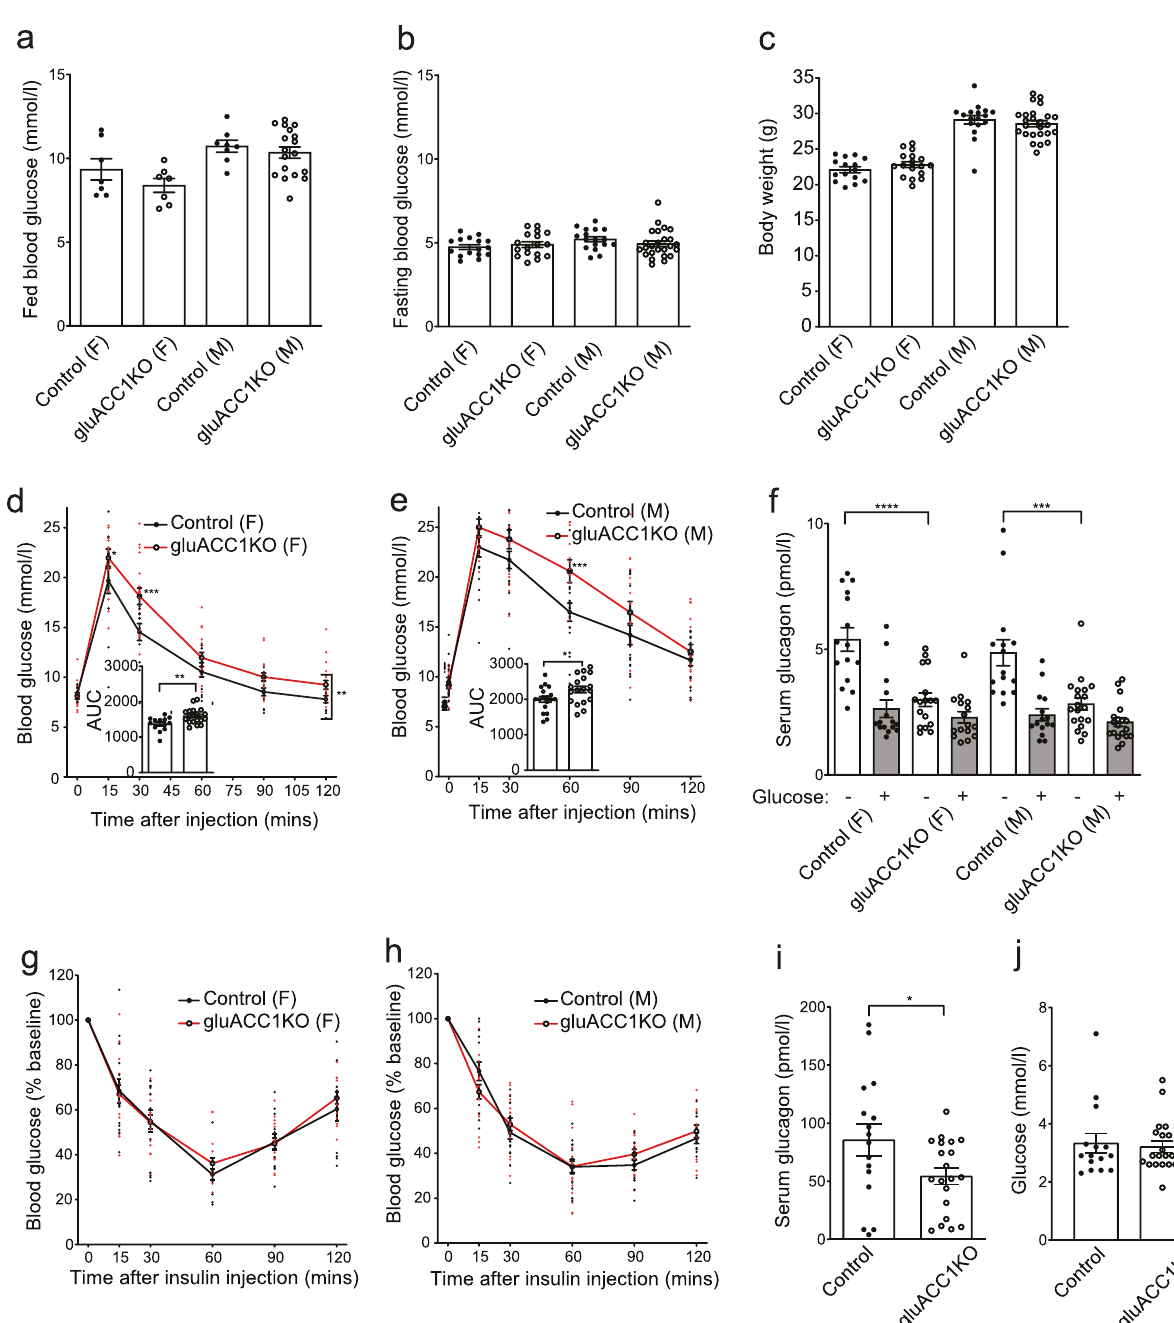
Fig. 2 Genetic inactivation of ACC1 in alpha-cells impairs glucagon secretion in vivo. a , b Blood glucose levels measured in 20 – 22 week old control (black circles) and gluACC1KO (white circles) mice in the fed ( a ; n = 7 – 18) and 16 h fasted ( b ; n = 16 – 25) states. c Body weight measured in 20 – 22-week-old control (black circles) and gluACC1KO (white circles) mice ( n = 15 – 25 mice). d , e Blood glucose levels and AUC during an IPGTT (6 h fast; 2 g/kg glucose dose) performed in 12 – 14-week-old female ( d ; n = 13 – 19) and male ( e ; n = 18) mice. Trace data analysed by two-way ANOVA ( P = 0.0009 for genotype effect in ( d ) with Fisher ’ s LSD test indicated. AUC was analysed by t -test. f Serum glucagon levels during the IPGTT at time 0 (white bars) and 30 min post-glucose injection (grey bars). Data from n = 15 – 19 mice analysed by t -test. g , h Insulin tolerance test (ITT) performed following 6 h fasting in female mice injected i.p. with 0.5 U/kg insulin ( g ; n = 16-17), or male mice injected i.p. with 0.75 U/kg insulin ( h ; n = 16 – 19). i , j Serum glucagon ( i ) and blood glucose ( j ) concentrations 60 min post-insulin injection in female mice. Data from n = 16 – 20 mice analysed by t -test. Data presented as mean ± SEM, for female (F) and male (M) mice as indicated. Signi fi cance thresholds: * P < 0.05, ** P < 0.01, *** P < 0.001, **** P <